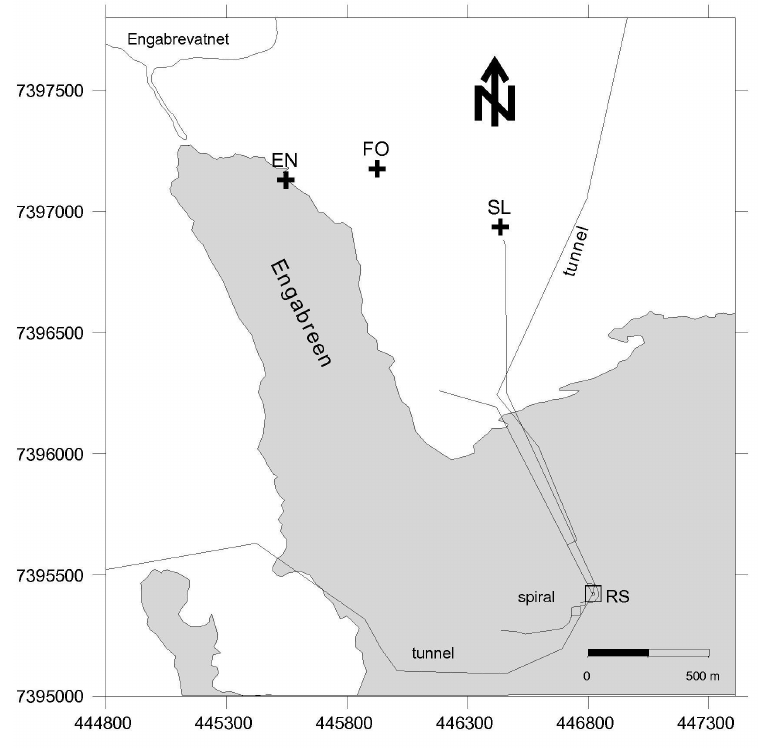
Map of Engabreen area with locations of the subaerial stream sampling sites and water access tunnels (black lines). EN—englacial stream; FO—forest stream; The proglacial